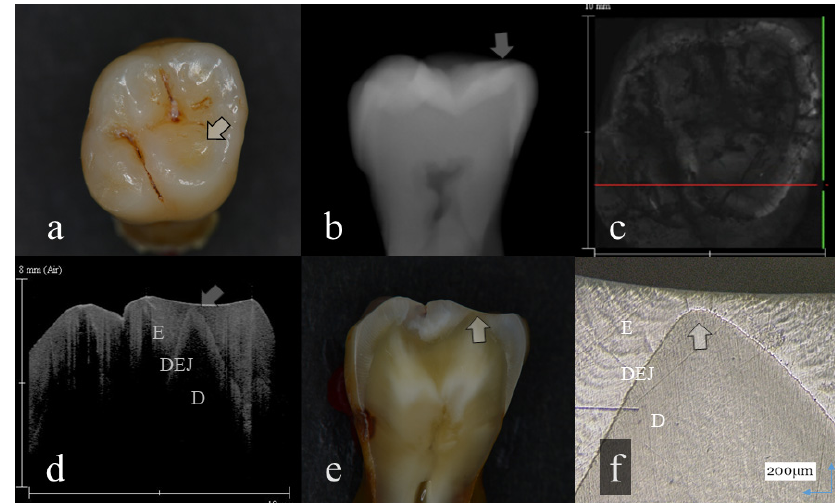
Figure 2. Distinct enamel wear without dentin exposure (score 2): ( a ): Occlusal view. The surface of mesial lingual cusp appeared slightly collapsed (arrow); ( b ): Digital intraoral radiography. Occlusal surface of mesial cusp appeared flattened (arrow); ( c ): OCT en face intensity projection; ( d ): SS-OCT image. Occlusal enamel remaining on the lingual cusp was extremely thin because of the tooth wear.